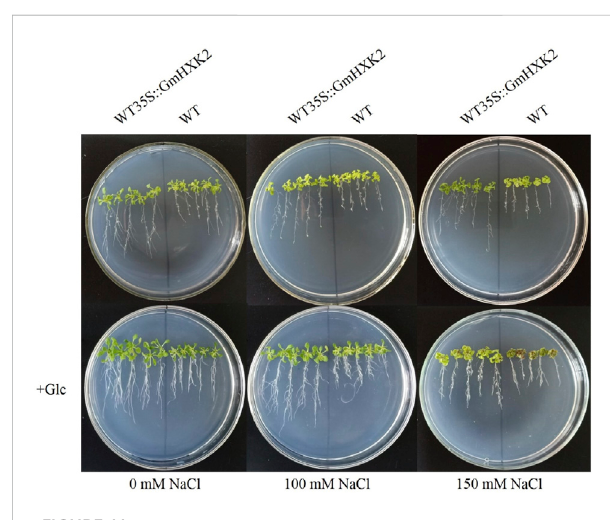
FIGURE 11 The phenotype of WT and WT35S:: GmHXK2 transgenic Arabidopsis plants under salt stress. Glc represents 100 mM glucose